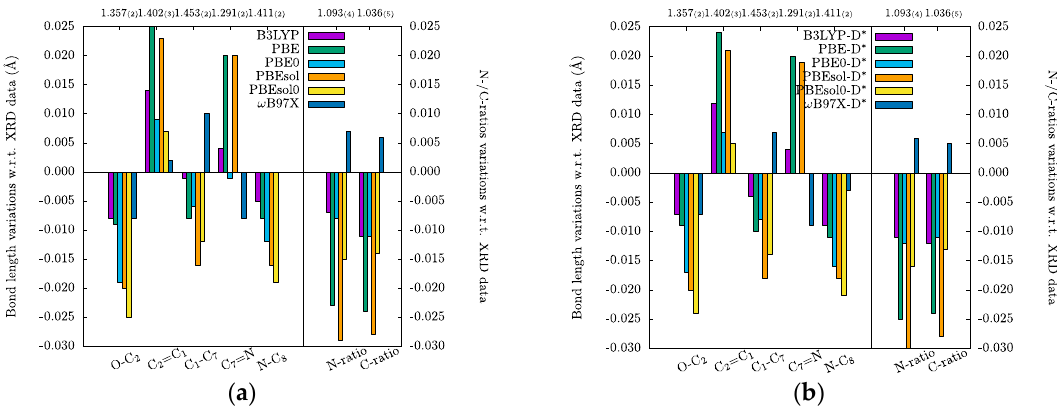
Figure 3. Differences between the bond lengths of the optimized structure and of the XRD data as a function of the XCF, Δ = [d(DFT) − d(XRD)]: ( a ) with DFT; ( b ) with DFT-D*. The XRD values are given